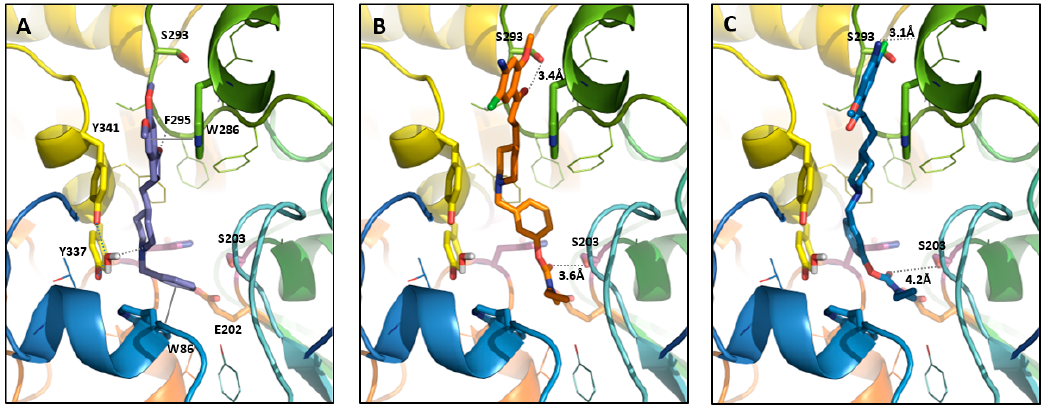
Figure 3. Donepezil position from the X-ray structure ( A ) compared to the compound 7 positioned in ( h )AChE binding sites using the docking studies, cluster 1 ( B ) and cluster 2 ( C ). The compound and the selected side chains of the binding site residues are in stick and the protein in ribbon representation. This figure was made with PyMOL (DeLano Scientific, 2002, San Carlo, USA). 2.3. In Vitro Results.